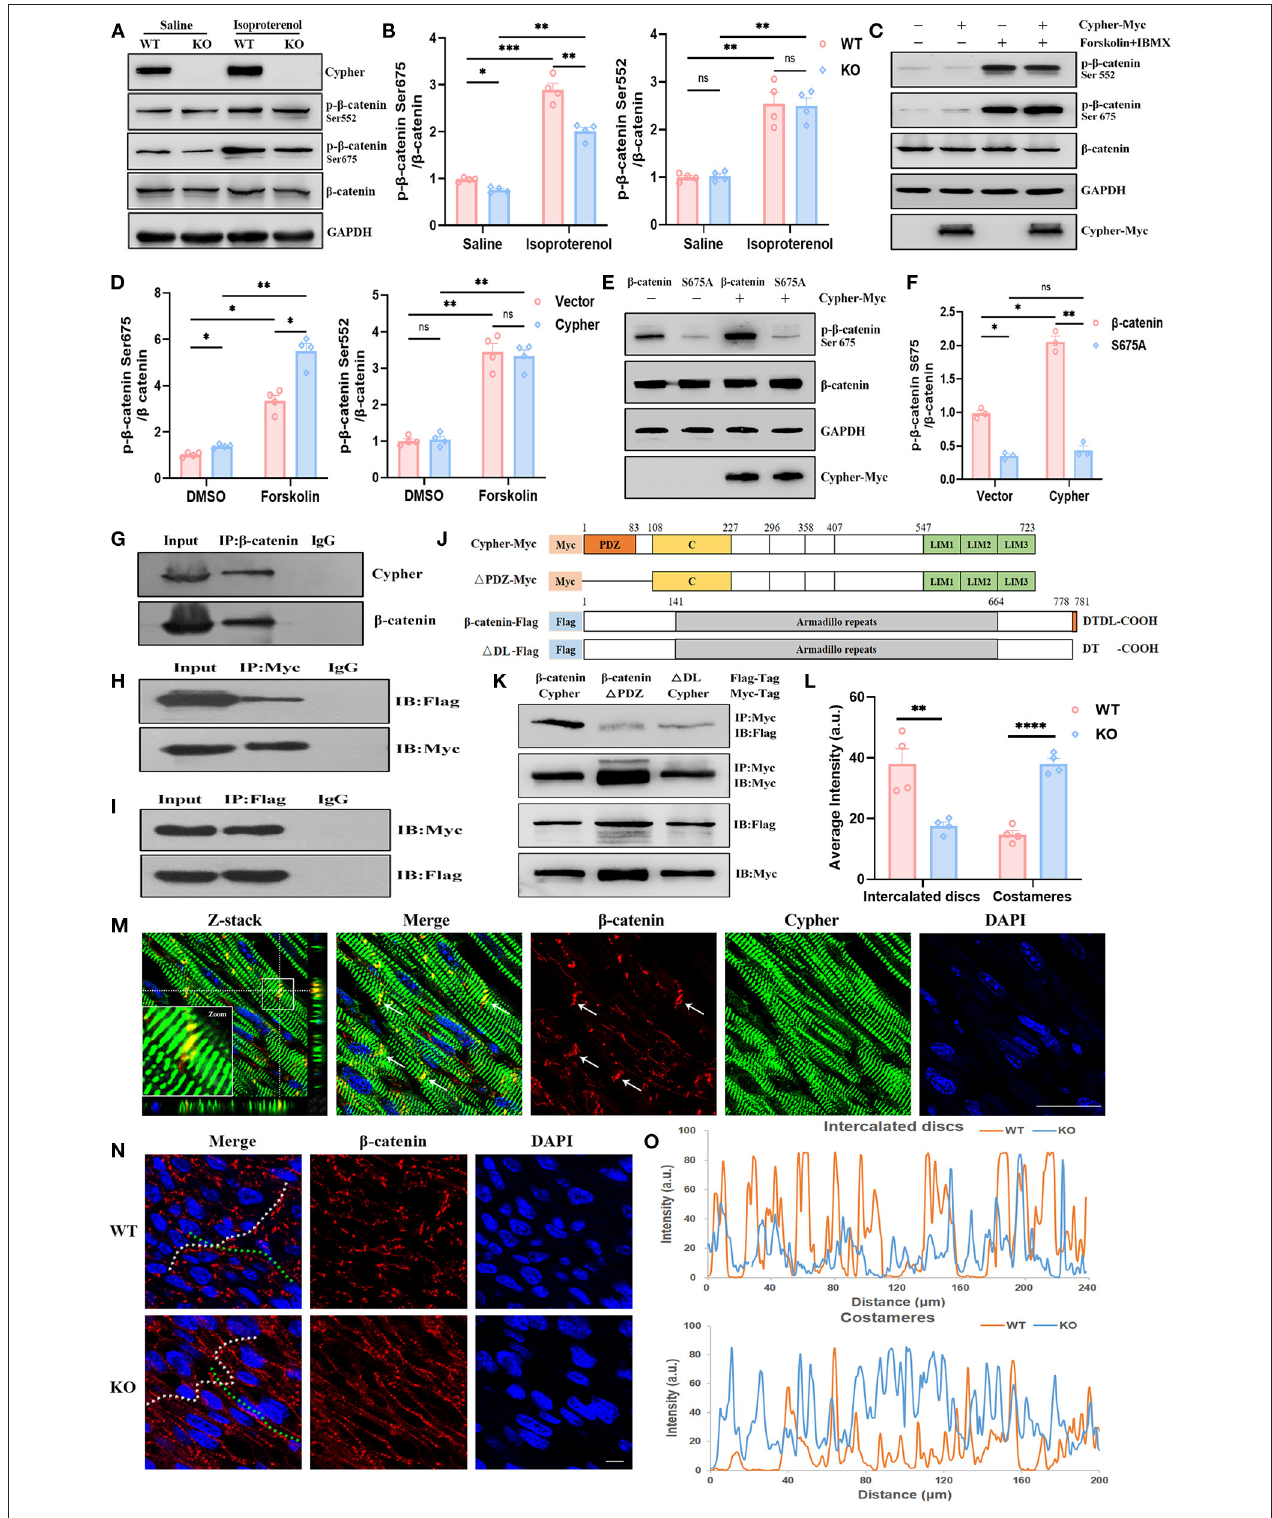
FIGURE 4 | Cypher interacts with β -catenin and facilitates its phosphorylation at Ser675 by PKA. (A) Western blotting for β -catenin and its phosphorylation using heart lysates from neonatal WT and Cypher-KO mice. Isoproterenol (15 mg/kg, 30min) was administered by intraperitoneal infusion before harvesting. (B) Quantification